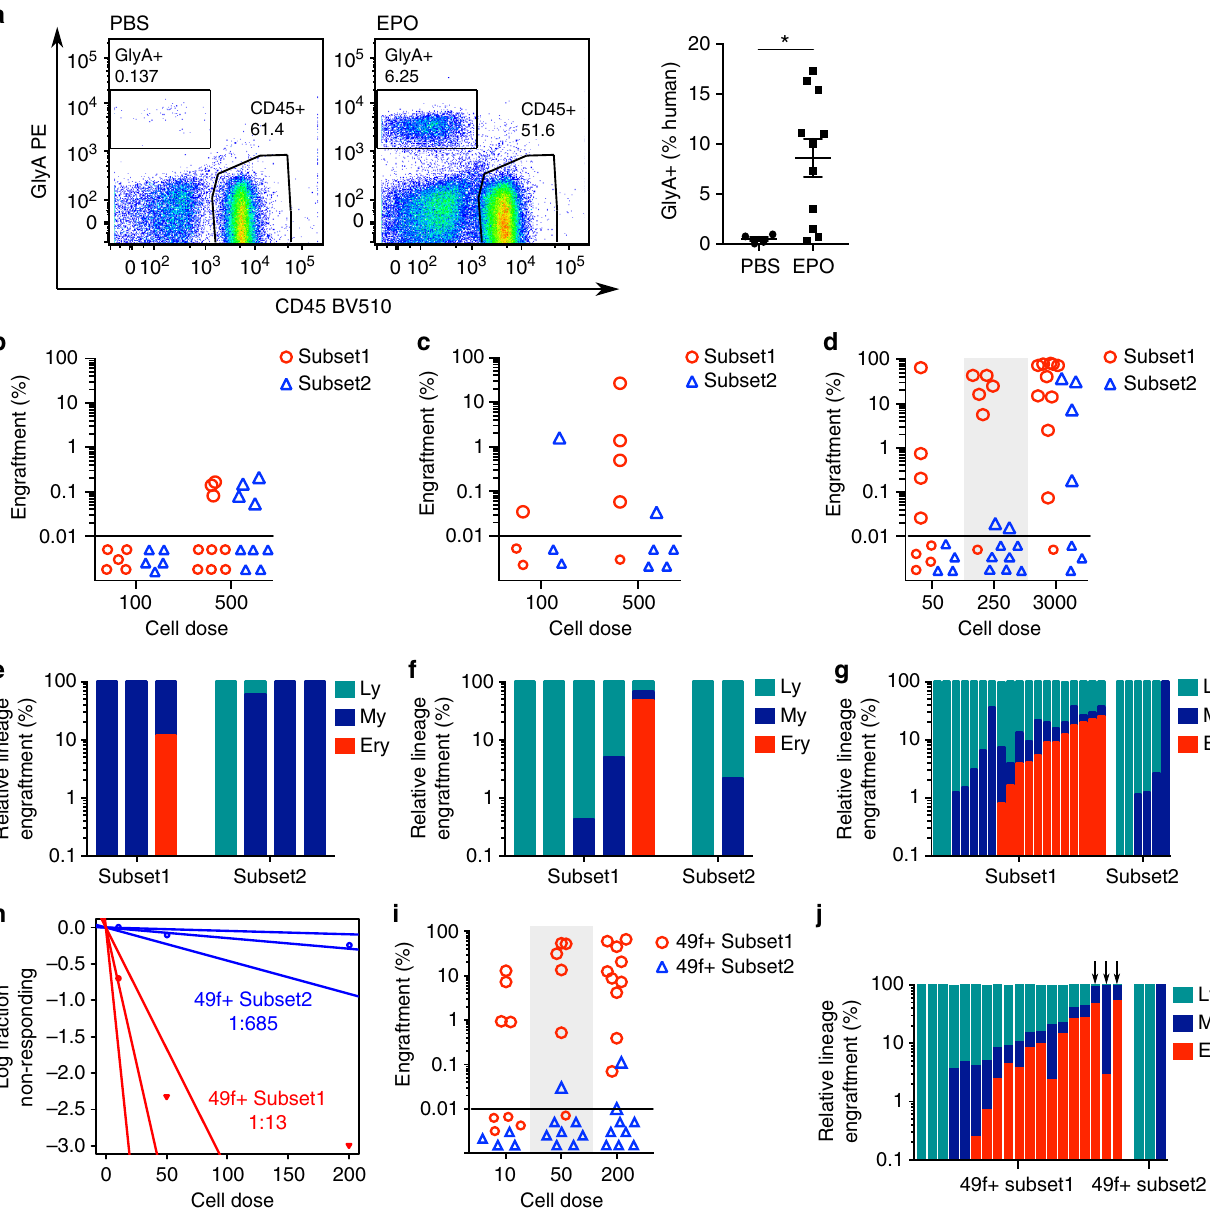
Fig. 5 Distinct long-term repopulation and differentiation capacities of Subset1 and Subset2 cells in vivo. a Left: Representative fl ow cytometry plots from the injected femur of mice engrafted with CB CD34 + cells and injected with seven doses of PBS (control) or EPO (20 units/injection). Right: relative Ery engraftment (percentage of total human engrafted cells), shown is mean ± SEM, * p < 0.05 by unpaired Mann – Whitney test. PBS: n = 4 mice, EPO: n = 11 mice. b – d Percentage of human engraftment (%CD45 ++ + %GlyA + ) in the injected femur of mice transplanted with Subset1 (red) or Subset2 (blue) cells at 2 weeks ( b , n = 14 transplanted mice per population), 8 weeks ( c , n = 8 transplanted mice per population) and 20 weeks ( d , n = 25 transplanted mice for Subset1 and n = 20 transplanted mice for Subset2) after transplantation. Dashed line: threshold of engraftment (%CD45 ++ + %GlyA + ) ≥ 0.01 % and at least 30 cells recorded. Non-engrafted mice shown below dashed line. CD45 ++ indicates cells positive for two distinct CD45 antibodies. e – g Distribution of differentiated cell types from each indicated lineage in the human graft of individual mice (injected femur, each bar represents one mouse) engrafted with Subset1 or Subset2 cells at 2 weeks ( e ), 8 weeks ( f ) and 20 weeks ( g ) after transplantation. My lineage: CD33 + cells; Ly lineage: CD19 ++ cells (positive for two distinct CD19 antibodies); Ery lineage: GlyA + cells. e Subset1: n = 3, Subset2: n = 4. f Subset1: n = 5, Subset2: n = 2. g Subset1: n = 19, Subset2: n = 6. h Estimation of frequency of long-term repopulating cells within 49f + Subset1 and 49f + Subset2 cells at 20 weeks post- transplantation by ELDA. i Percentage of human engraftment (%CD45 ++ + %GlyA + ) in the injected femur of mice injected with 49f + Subset1 (red, n = 24 mice transplanted) or 49f + Subset2 (blue, n = 21 mice transplanted) cells at 20 weeks after transplantation. j Distribution of differentiated cell types belonging to each indicated lineage in the human graft of individual mice (injected femur, each bar represents one mouse) engrafted with 49f + Subset1 or 49f + Subset2 cells at 20 weeks after transplantation. 49f + Subset1: n = 19, 49f + Subset2: n = 3. Arrows indicate mice with unusually low levels of Ly